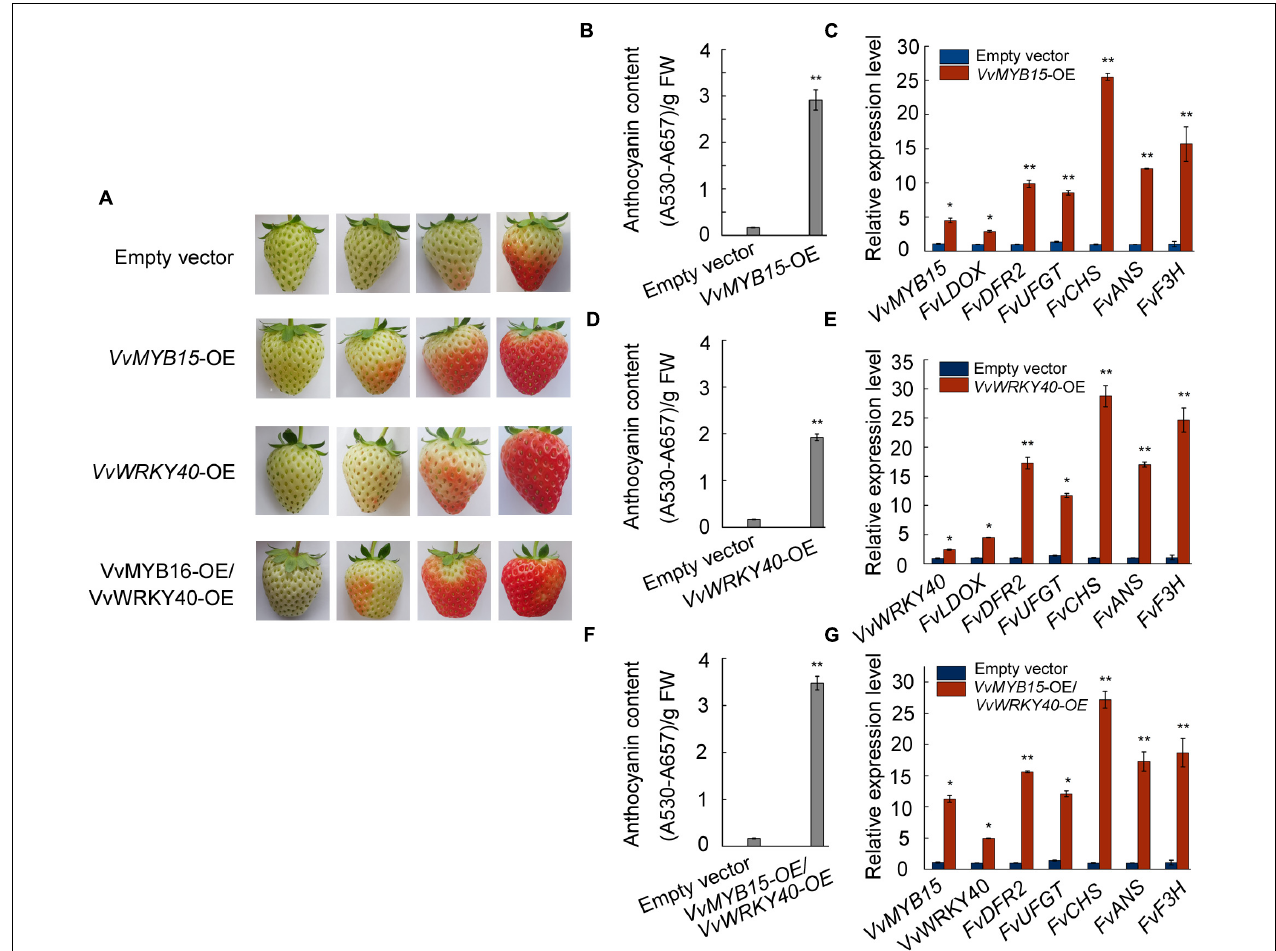
FIGURE 4 | VvMYB15 and VvWRKY40 promoted the anthocyanin accumulation in strawberry fruit. (A) Anthocyanin accumulation phenotypes and (B,D,F) relative anthocyanin contents of strawberry fruit of transient transformed A. tumefaciens harboring 35S-GFP empty (Control), 35S::VvMYB15 - GFP , 35S::VvWRKY40 - GFP or 35S::VvMYB15 - GFP / 35S::VvWRKY40 - GFP . The experiments were performed three times with similar results, and a representative picture is shown. (C,E,G) Expression analysis of VvMYB15 , VvWRKY40 and anthocyanin biosynthesis-related genes ( FvLDOX , FvDFR2 , FvUFGT , FvCHS , FvANS, and FvF3H ) in strawberry fruits were detected by qRT-PCR, 26S was used as internal control. Three biological replicates were performed, the error bars donate standard deviations. Asterisks represent different level of significance ( P ≤ 0.05*, P ≤ 0.01**), and significant differences is indicted by different lowercase letters based on independent sample t